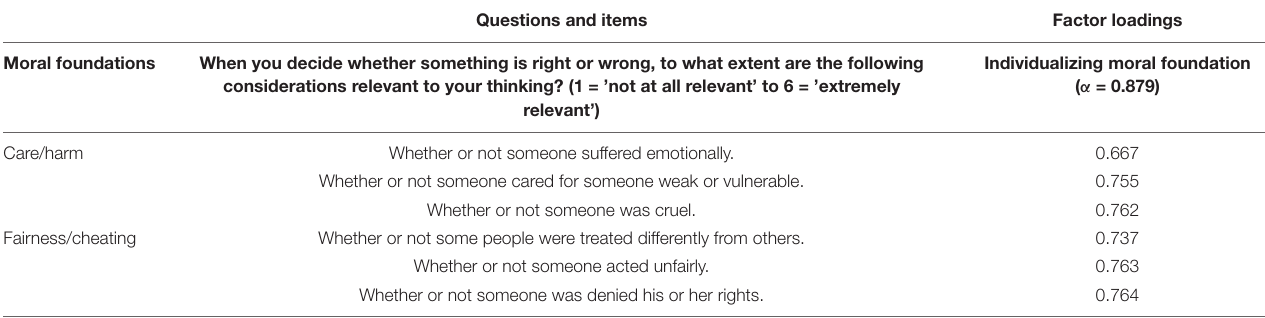
TABLE 5 | Factor matrix of MFQ-items (studies 1 and 3).